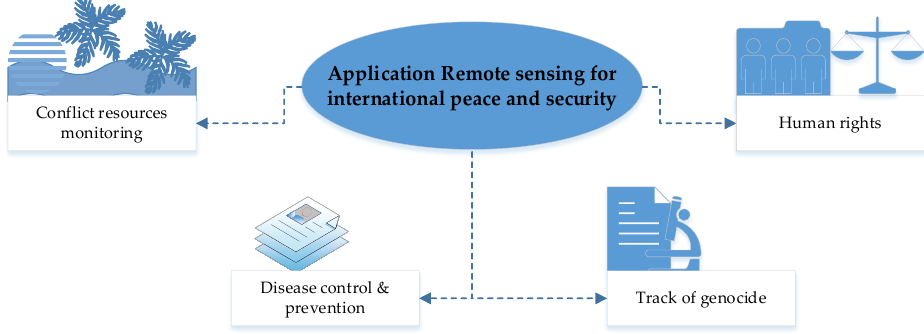
Figure 1. Applications of remote sensing for international peace and